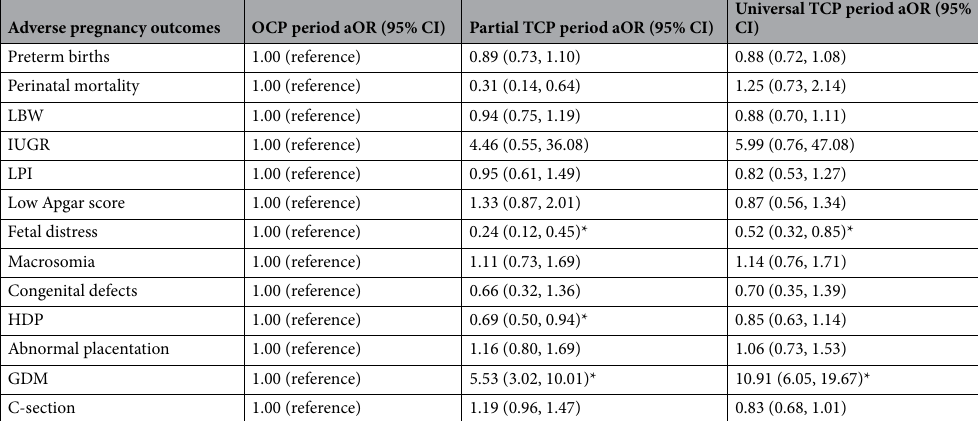
Table 5. Association between adverse pregnancy outcomes in women with AMA and policy changes. OCP (One-child policy), TCP (Two-child policy), AMA (advanced maternal age), LBW (low birth weight), IUGR (intrauterine growth retardation), LPI (low ponderal index), HDP (hypertensive disorders of pregnancy), GDM (gestational diabetes mellitus), Adjusted for maternal education, occupation, pre-pregnancy body weight, parity, and neonatal gender; * = P <